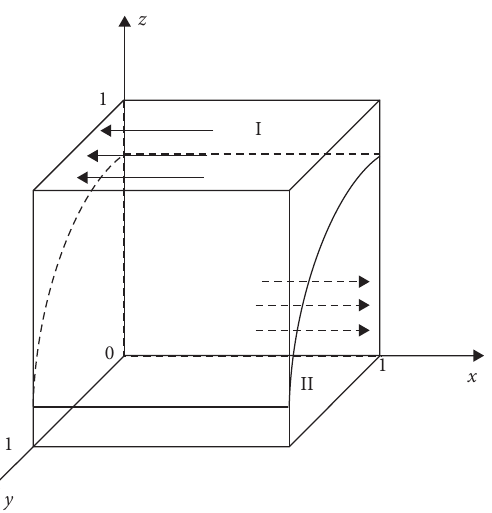
Figure 1: The local government’s dynamic